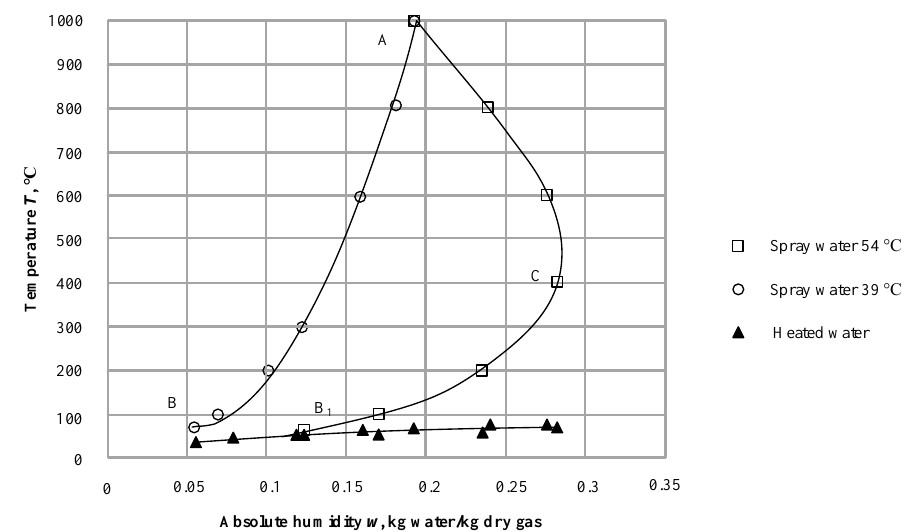
Fig. 4. Alterations of gases, water temperature and humidity content in direct contact heat